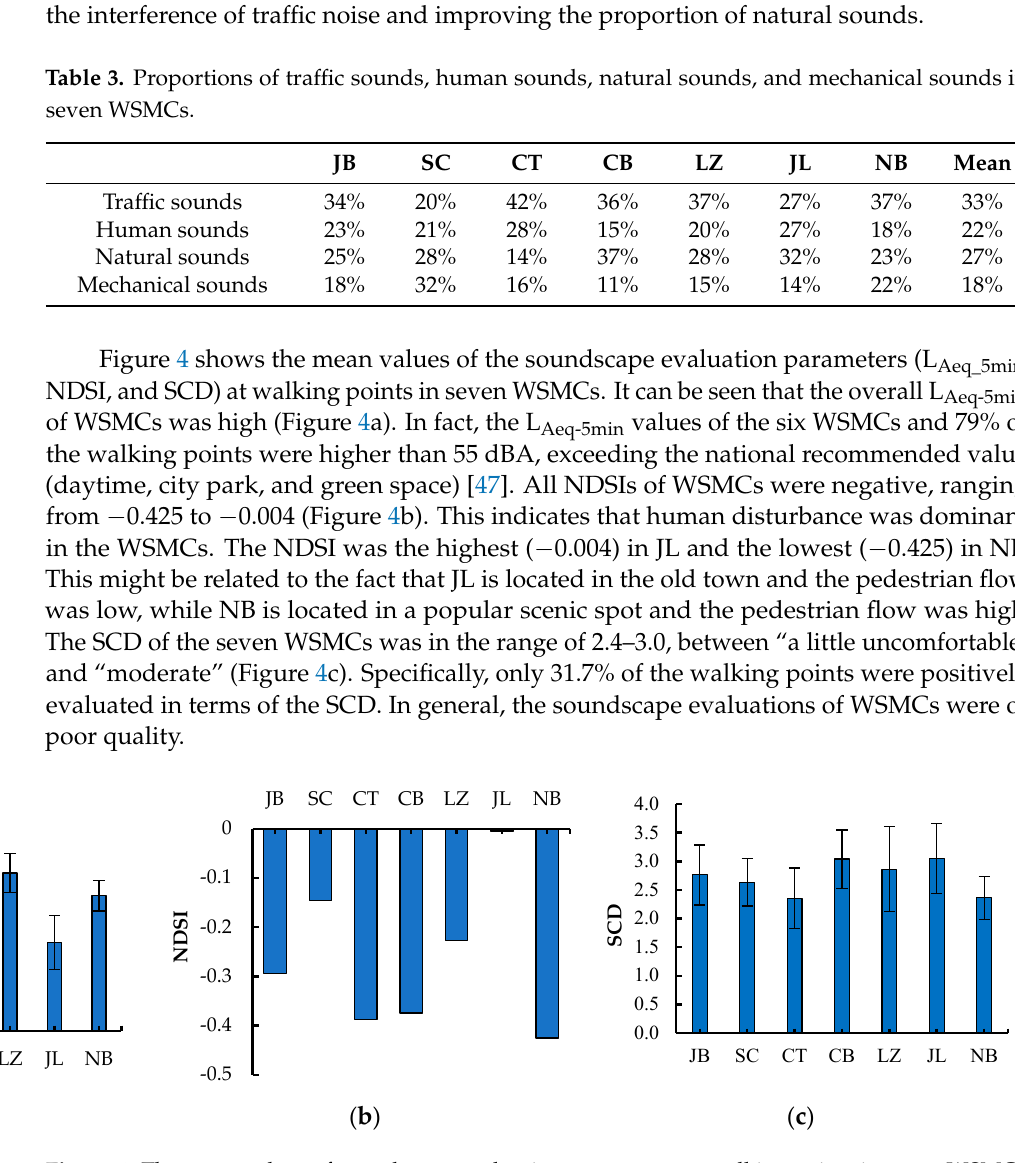
Figure 4. The mean values of soundscape evaluation parameters at walking points in seven WSMCs. ( a ) L Aeq_5min , ( b ) NDSI, and ( c ) SCD. L Aeq_5min = A-weighted equivalent sound level calculated every 5 min; NDSI = normalized soundscape difference index; SCD = soundscape comfort degree. All soundscape evaluation parameters are the average values for the area.